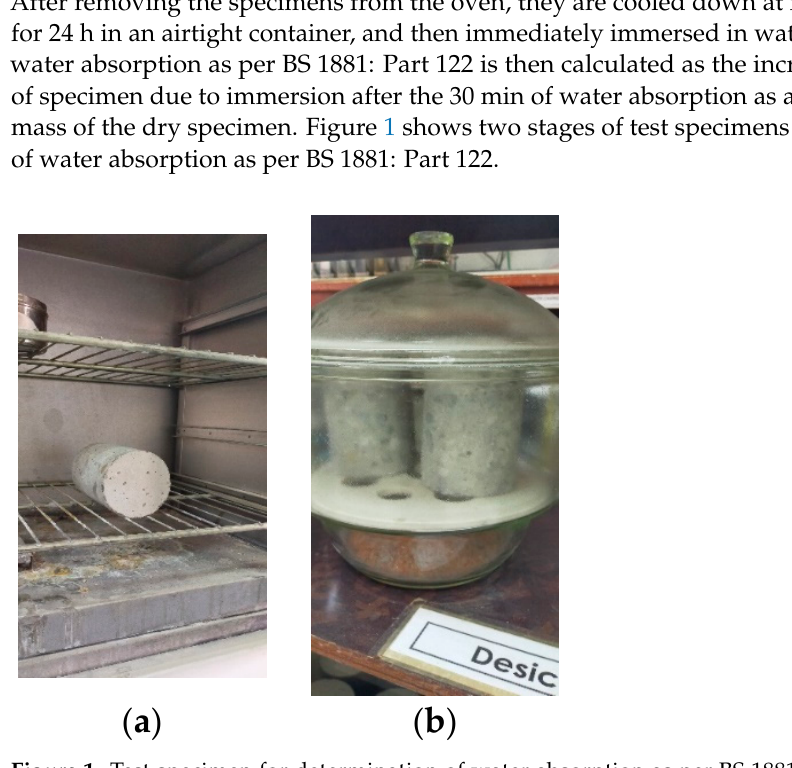
Figure 1. Test specimen for determination of water absorption as per BS 1881: Part 122: ( a ) oven drying of concrete specimen; and ( b ) cooling down of specimens in a desiccator.